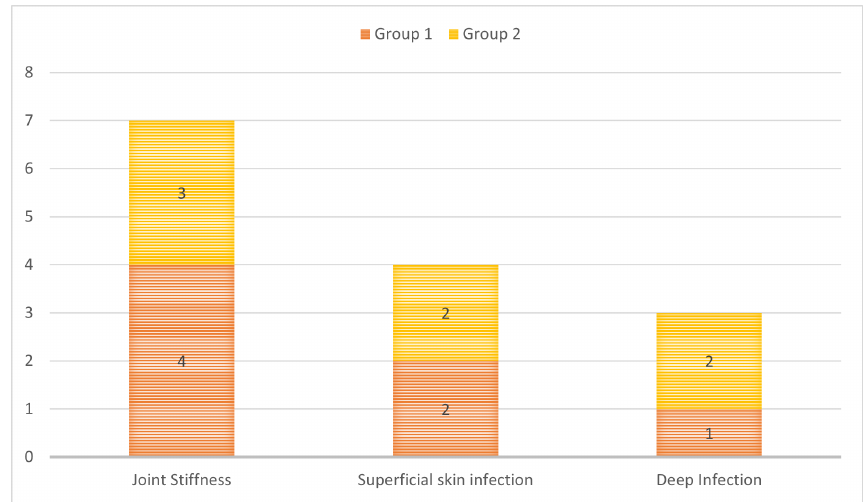
Figure 1. Post- operative range of motion in both groups